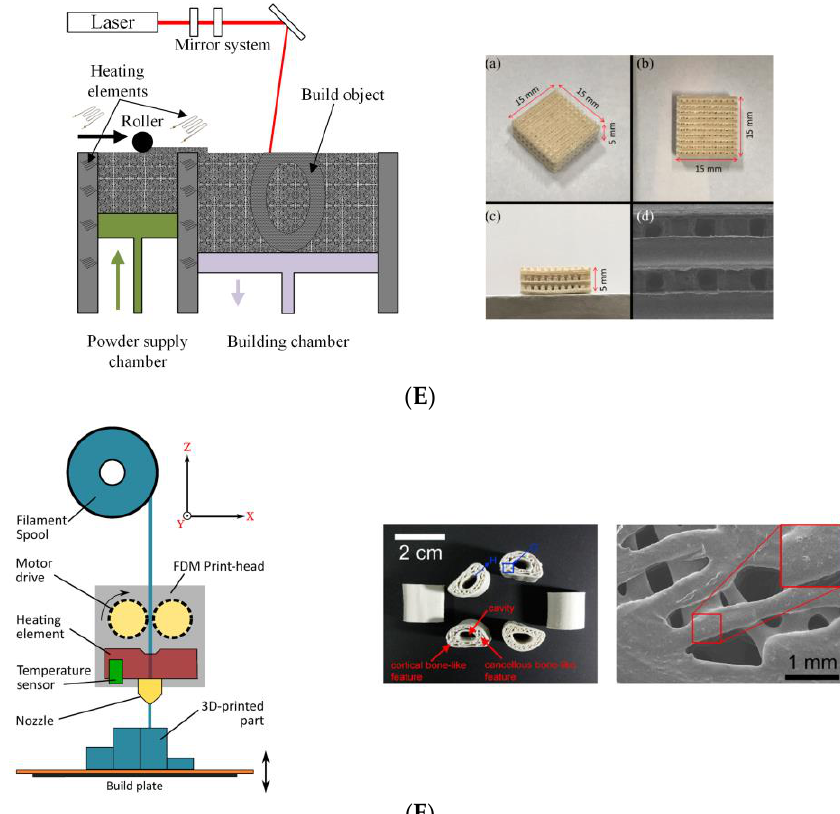
Figure 4. Examples of conventional and advanced preparation methods for polymeric scaffolds: ( A ) freeze drying [102]; ( B ) solvent-casting particulate leaching [106]; ( C ) thermally induced phase separation [102]; ( D ) electrospinning [102]; ( E ) selective laser sintering (( a – c ) optical images and ( d ) SEM image) [2,111]; ( F ) fused deposition modeling [112,115] (( A – D ) ( right ), ( E ), and ( F ) ( left ) are licensed under CC-BY 4.0; ( F ) ( right ) is adapted with permission from Xu, N. et al.; 3D artificial bones for bone repair prepared by computed-tomography-guided fused deposition modeling for bone repair; copyright 2023 American Chemical Society).